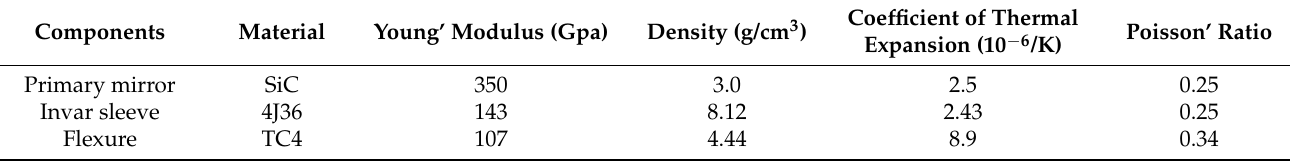
Table 2. Material properties of the mirror assembly.